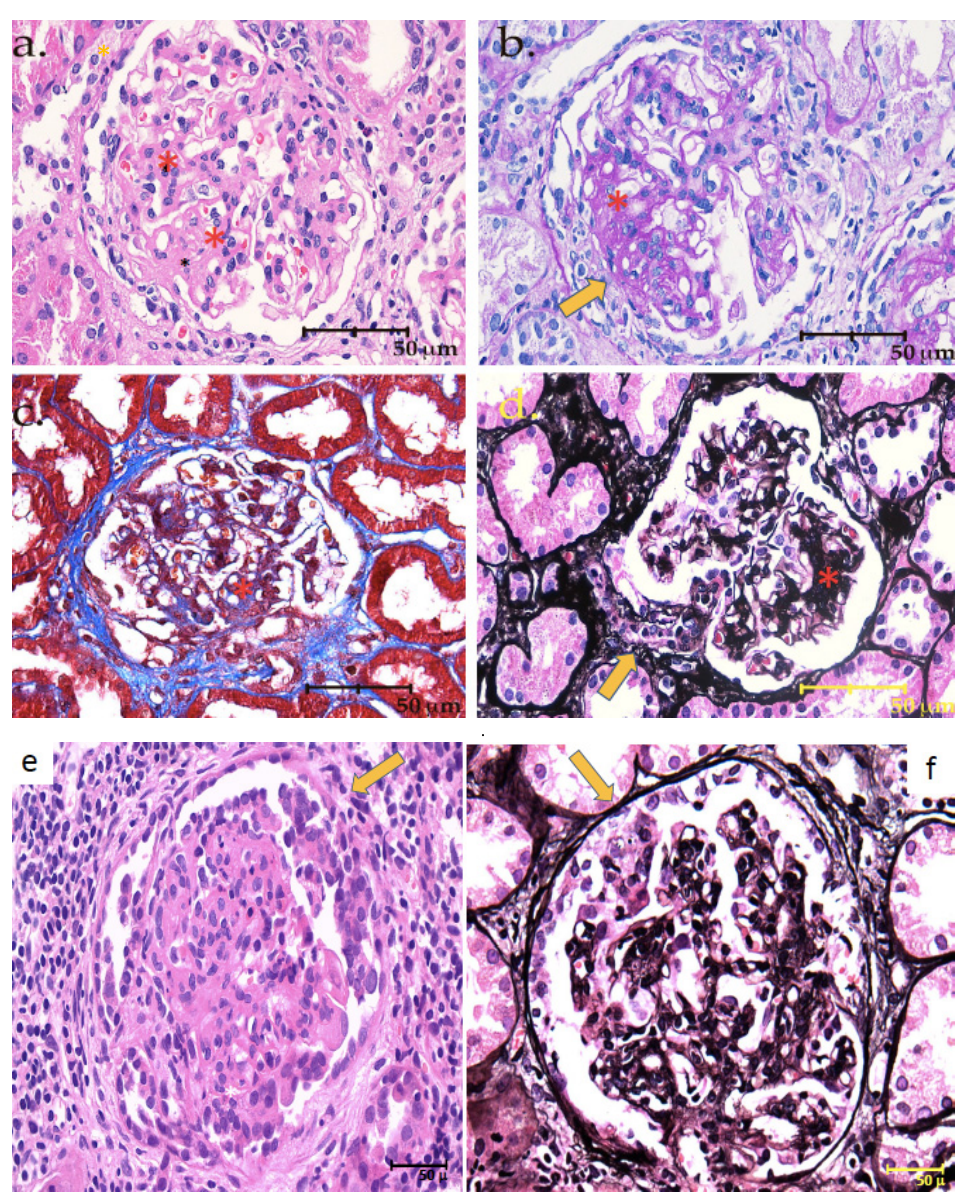
Figure 2. 400× microphotographs stained with HE ( a , e ), PAS ( b ), Masson’s trichrome ( c ), and Jones’ methenamine silver ( d , f ), respectively, in which different glomeruli with global mesangial widening and proliferation (M1) with cicatricial segmental sclerosing lesions (S1) are observed). Asterisks show mesangial proliferation ( a – d ). Arrows shows segmentary sclerosis in the tip ( b , d ). In the last two images we can see glomeruli with podocyte hypertrophy, forming crowns around some segments of the capillaries